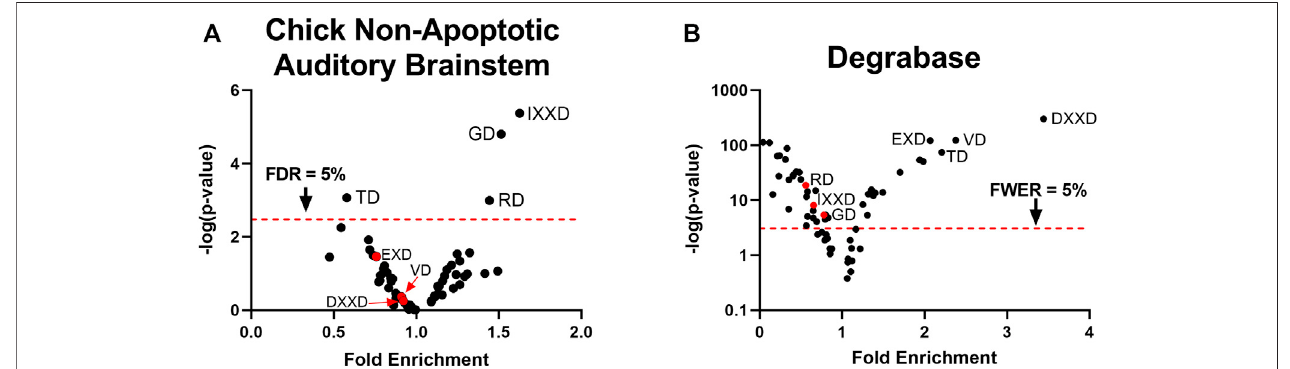
FIGURE 1 | Caspase activity prefers a non-canonical consensus sequence in the non-apoptotic chick auditory brainstem. (A) Hypergeometric tests were used to compare observed and expected frequencies of each of the 60 P4-P2 motifs at aspartic cleavage sites in the chick auditory brainstem. Expected frequencies were estimated as the proportion of each motif preceding all aspartates in the protein sequences of substrates, adjusted for the number of replicates in which each substrate was cleaved. We found a positive enrichment for the motifs IXXD, GD, and RD, yielding a consensus sequence of IX(G/R)D. (B) As a point of reference for the non- apoptoticconsensussequence,weusedthesamemethodtocompareobservedandexpectedfrequenciesofP4-P2motifsatasparticcleavagesitesintheDegrabase, a published database of neo-N-termini from apoptotic human cell lines. As expected, the Degrabase exhibited a consensus sequence of DEVD, the preferred P4-P1 sequenceofexecutioner caspase-3and-7.Bycontrast,theDegrabaseshowedanegativeenrichment fortheconsensussequenceofthenon-apoptoticchickauditory brainstem,suggesting thatcaspase activityinthechickauditorybrainstem isdirectedtowardsiteswithaP4-P2sequencedistinctfromthatobservedduringapoptosis. FDR: False Discovery Rate, derived by Benjamini, Krieger and Yekutieli correction. FWER: Family-Wise Error Rate, derived by Bonferroni